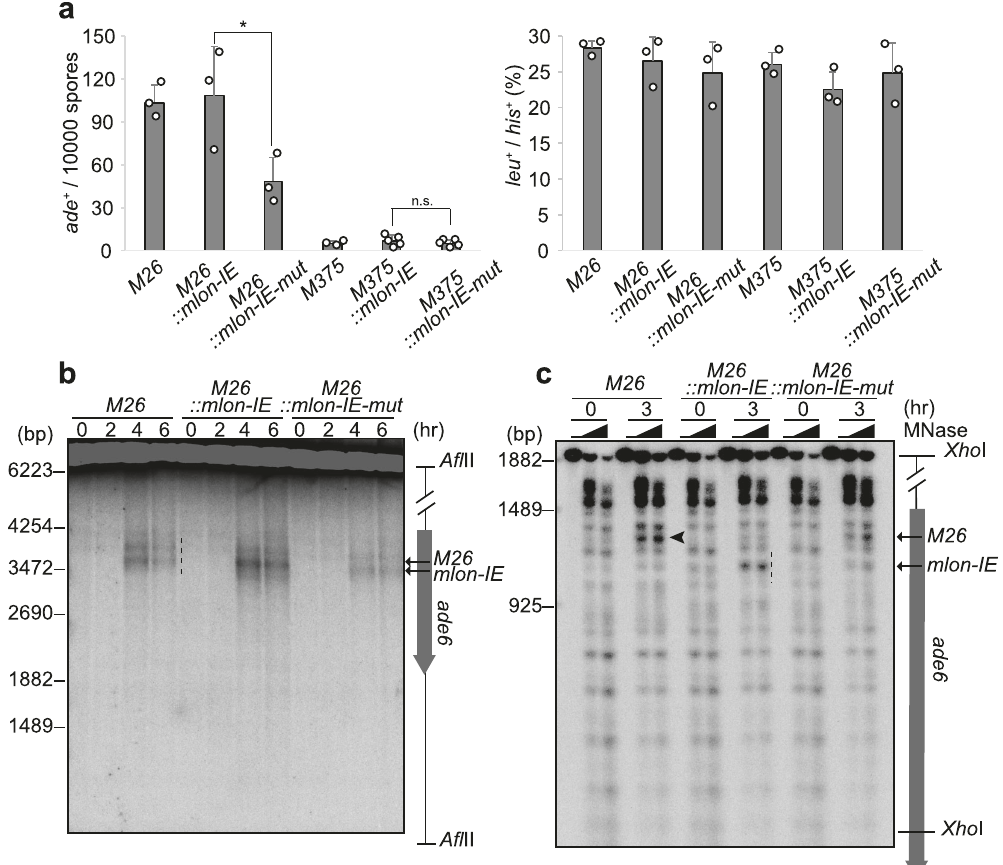
Fig. 2 Transcription from mlon-IE activates meiotic DSB formation and recombination in ade6-M26 , the meiotic recombination hotspot. a Recombination rates at the M26 or M375 control allele (indicated as ade + /10 4 spores) were examined, as described in the Methods section (left). Recombination between leu1-32 and his3-D1 (indicated as leu + / his + percentage) was measured as the control (right). Error bars represent standard deviations. n = 3 or 5 biologically independent experiments. P values were calculated using the unpaired one-sided Student ’ s t -test: * P < 0.05, n.s. (not signi fi cant). b Indicated haploid cells possessing the pat1-114 rad50s genotype were cultured to induce meiosis, and DNA was prepared as described in the Methods section. Meiotic DSBs were detected by Southern blotting. The dotted line indicates DSBs around M26 and inserted mlon-IE . c Meiotic chromatin remodeling in indicated cells. Diploid cells were cultured as in Fig. 1c. The black arrowhead and the dotted line indicate MNase-sensitive sites at the M26 mutation and the inserted mlon-IE ,